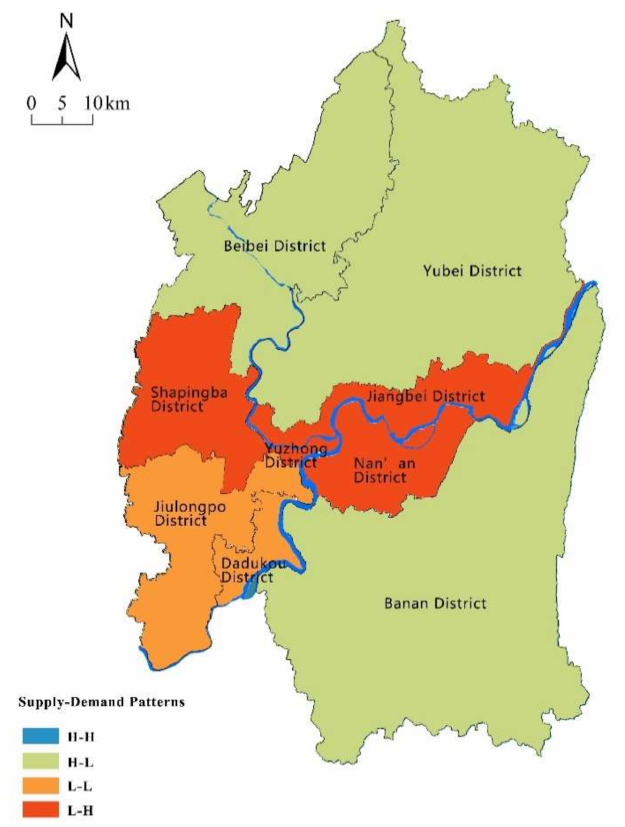
Figure 8. Distribution of supply–demand patterns of